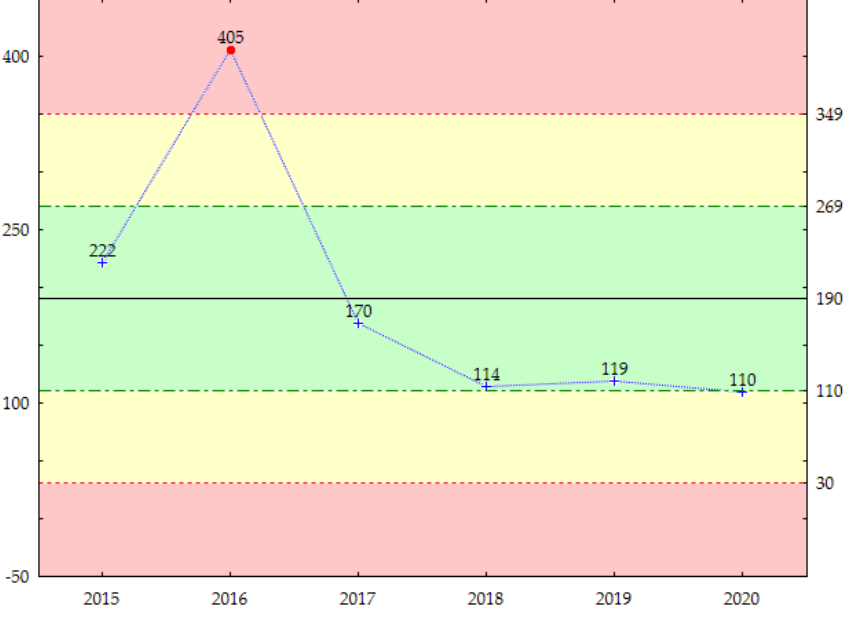
Figure 5. X-average control chart for the average distance traveled by 1 ton of goods by inland waterway transport on all sections route of the Odra River. Note: The central line for the average distance traveled by 1 ton of goods is 190.06 km, and sigma for the average distance traveled by 1 ton of goods is equal to 79.82 km. Source: own elaboration.